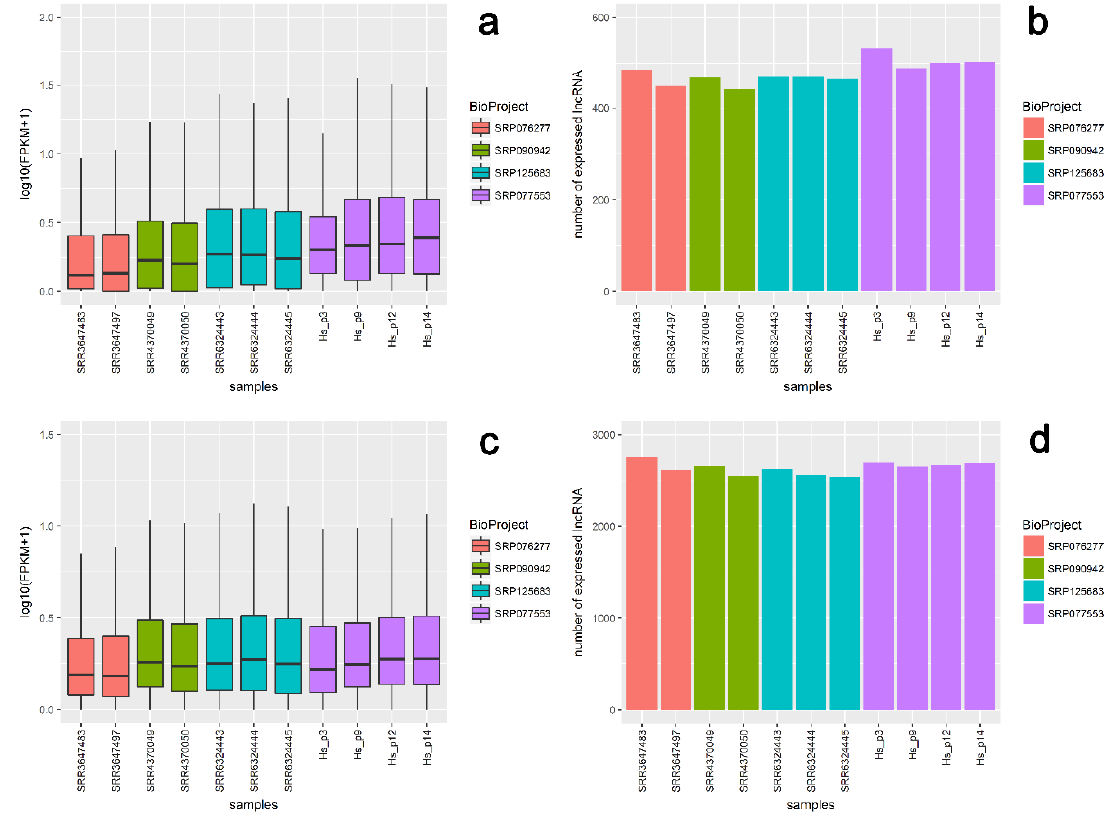
Figure 8. Comparison of transcript expression level distribution between external datasets downloaded from BioProjects SRP076277 (BioSamples SRR3647483 and SRR3647497), SRP090942 (BioSamples SRR4370049 and SRR4370050), SRP125683 (BioSamples SRR6324443, SRR6324444, and SRR6324445), and our dataset (Hs_p3, Hs_p9, Hs_p12, and Hs_p14). ( a , c ) Normalized FPKM distribution (box plots) and ( b , d ) sum of expression loci (bar graphs) for novel ( upper panel ) and known ( lower panel ) lncRNAs.